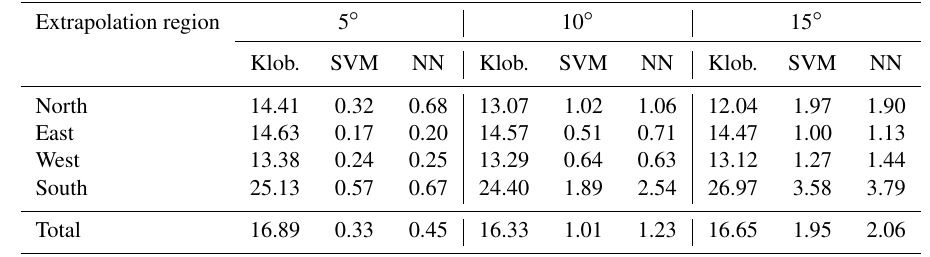
Table 3. One-month mean of extrapolation RMS errors with three parameterizations (SVM model, unit = TECU). Extrapolation region 5 ◦ 10 ◦ F10.7 SSN SSN + F10.7 F10.7 SSN + F10.7 SSN SSN + F10.7 North 0.31 0.31 East 1.00 West 0.26 0.26 South 0.66 Total 0.34 1.95 Table 4. One-month mean of extrapolation RMS errors with three parameterizations (NN model, unit = TECU). Extrapolation region 5 ◦ 10 ◦ 15 ◦ F10.7 SSN + F10.7 North 0.66 East West South